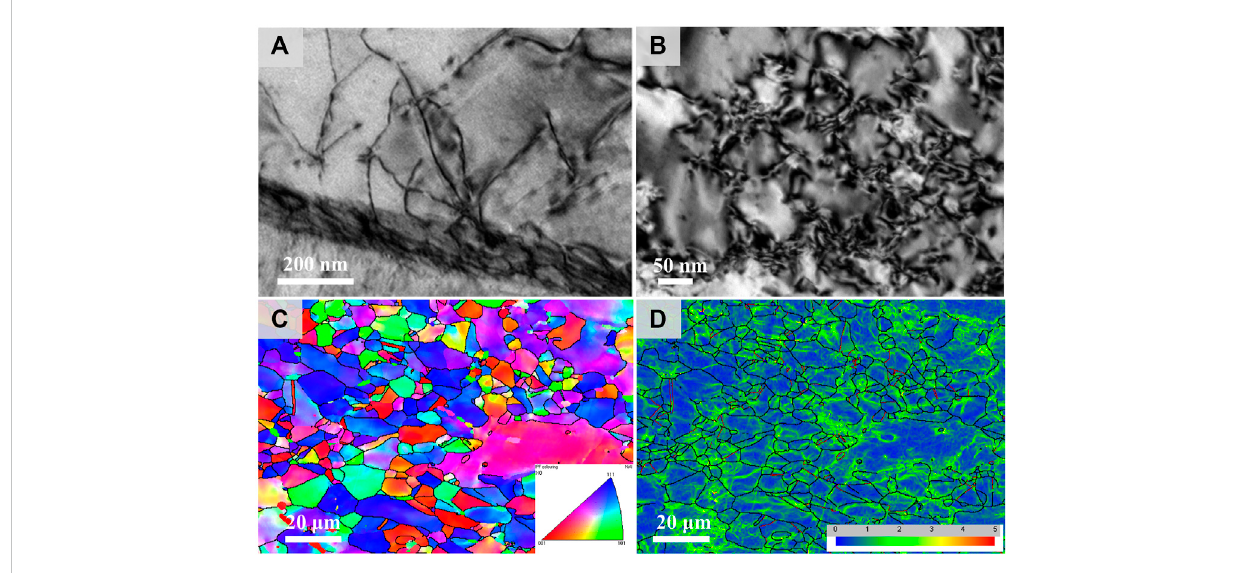
FIGURE 5 Bright- fi eld TEM micrograph of the L1 2 Ni 46.5 Co 24 Fe 8 Al 12.5 Ti 9 alloy after (A) 5% strain and (B) fracture. EBSD measurements of the fractured alloy (C, D)